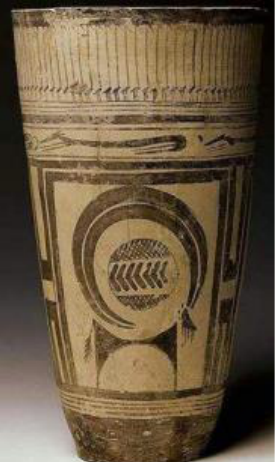
Figure 23. Susa Cup,